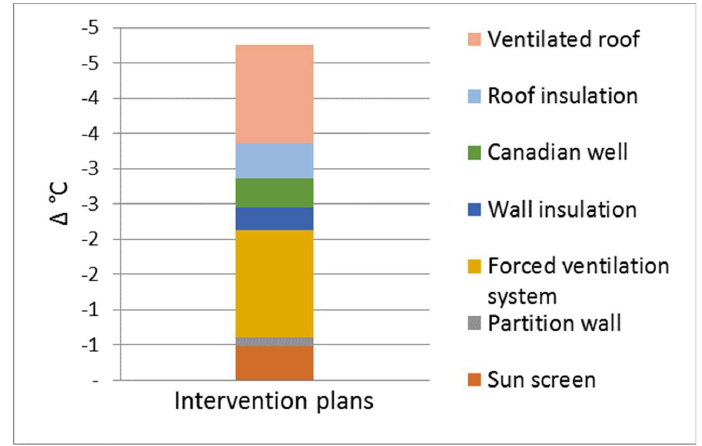
Figure 9. Decrease in temperature for each passive intervention.